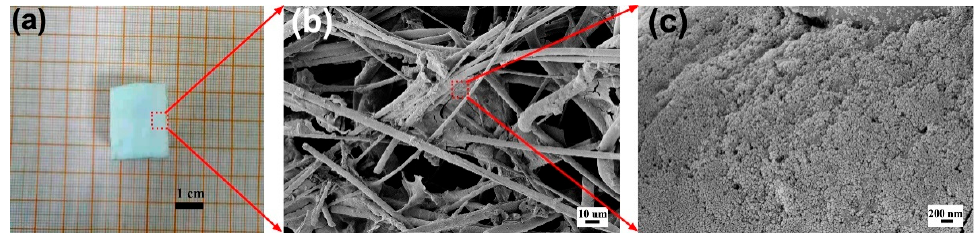
Figure 2. (a) Optical and (b, c) SEM images of the yttria-stabilized ZrO 2 fiber insulation tile.